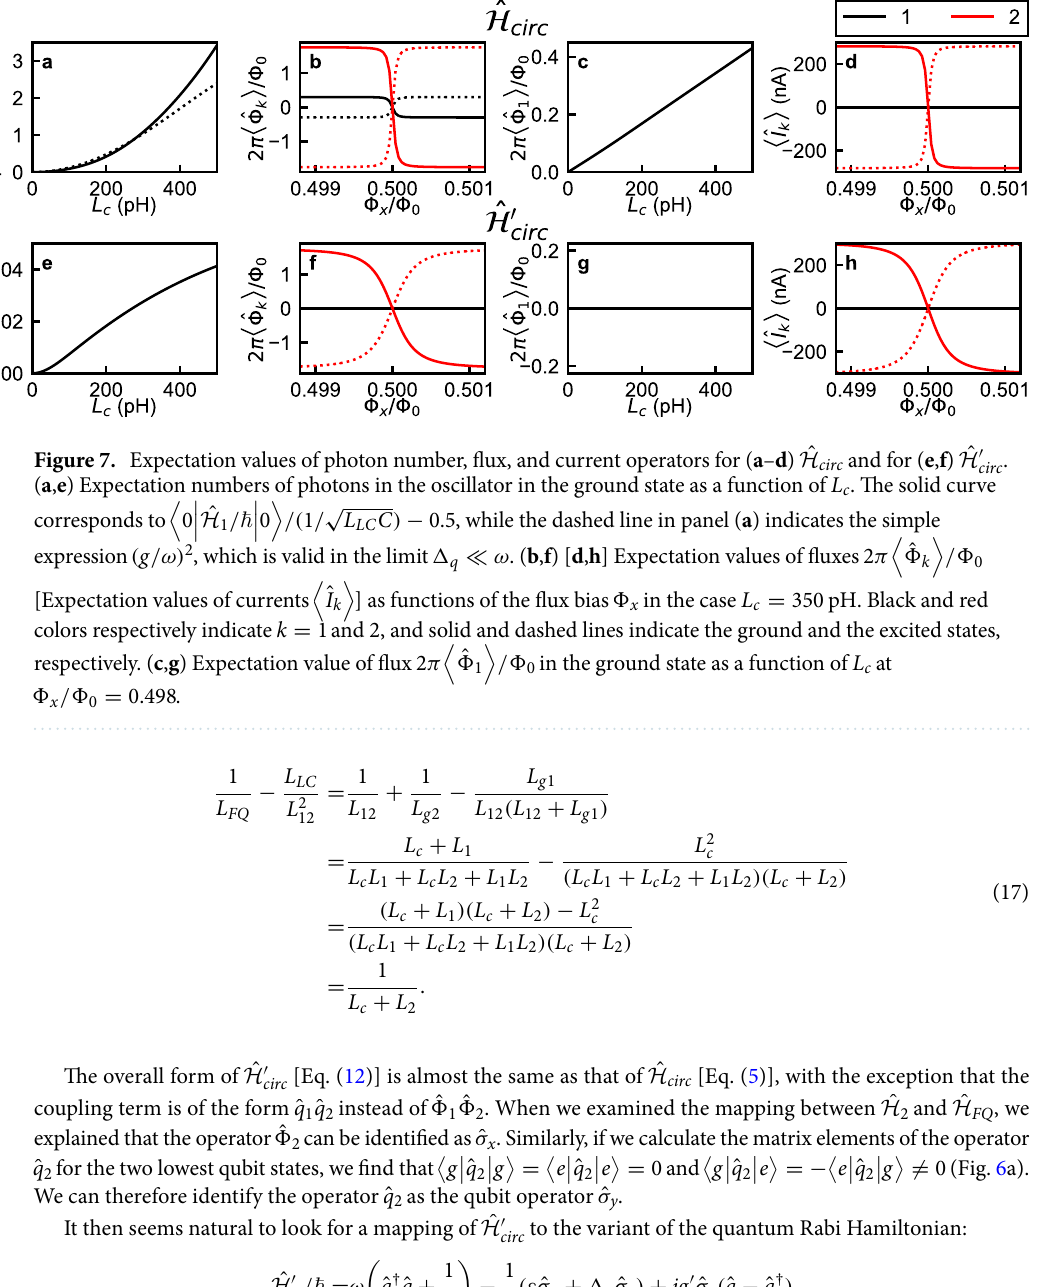
Contrary to the open grey and red circles obtained from ˆ H ′ circ , the solid grey and red lines obtained from ˆ H ′ R are